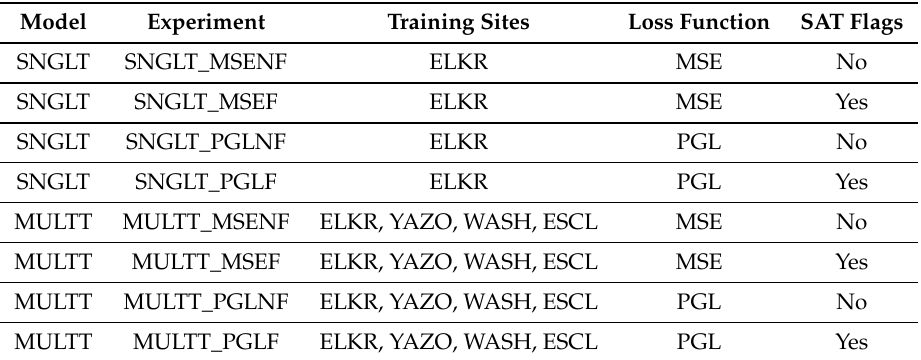
Table 4. Experimental design. Two model designs were trained and evaluated: (1) SNGLT was trained on the ELKR site only and tested on ELKR, YAZO, WASH, and ESCL sites individually and (2) MULTT was trained using data from all four sites at once, then evaluated on each site individually.